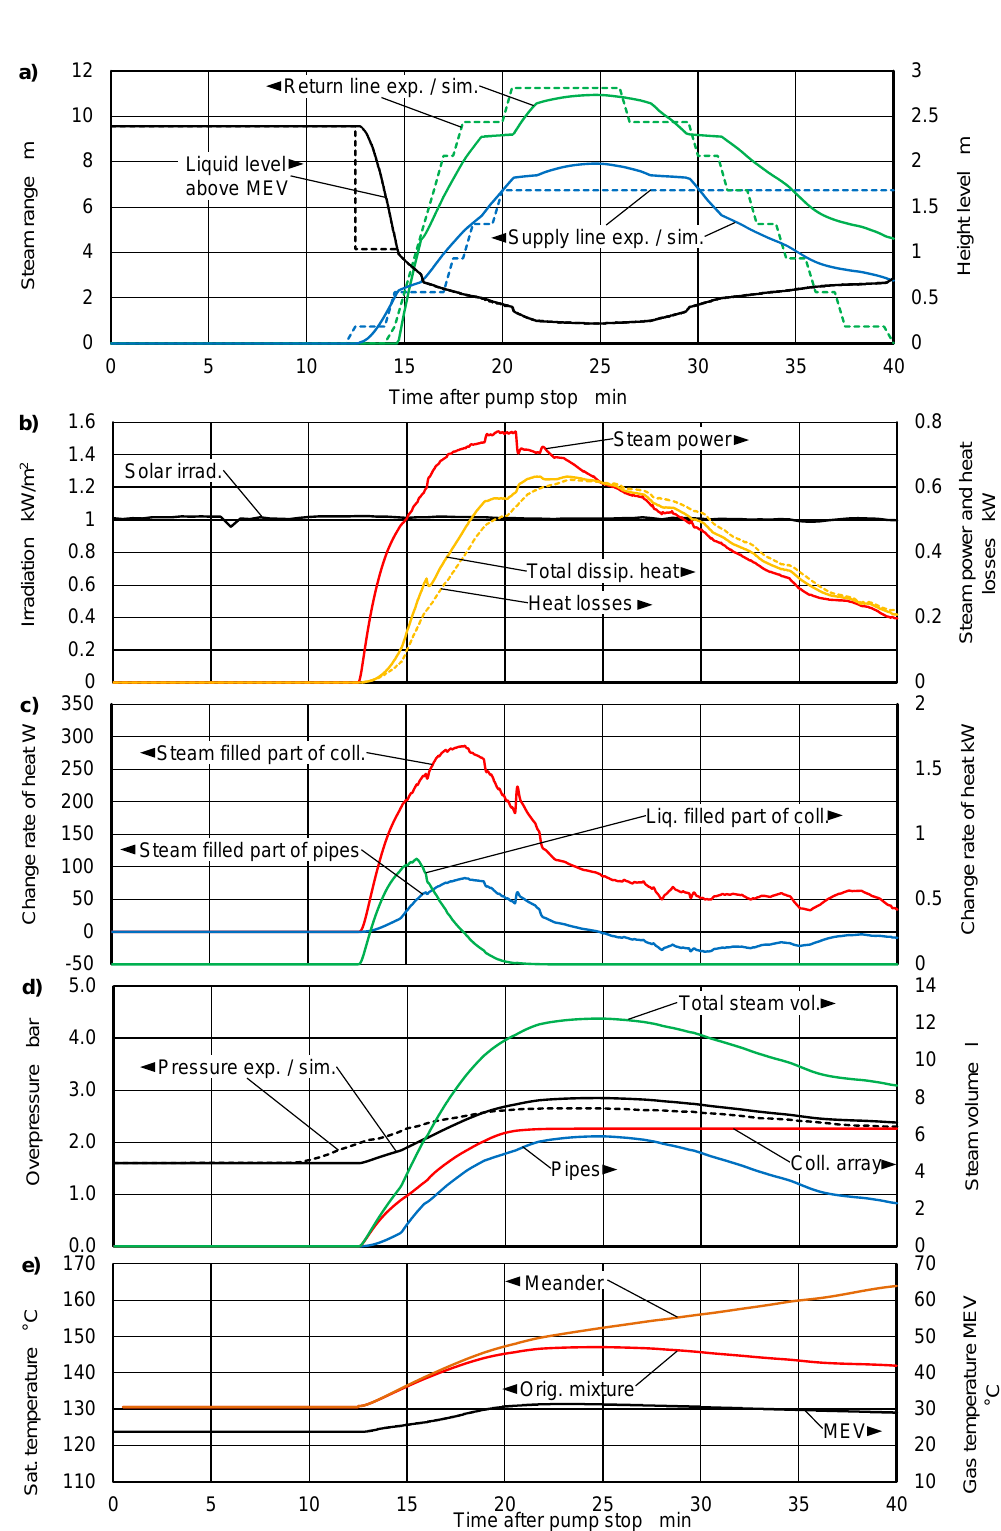
Figure 12. Experimental and simulation results for the system with standard selective absorbers. Opened check valves. Case 08−16. ( a ) Steam range and level height, ( b ) Steam power, heat losses and irradiation, ( c ) Change rates of heat, ( d ) Overpressure and steam volume, ( e ) Saturation temperature and gas temperature inside MEV.